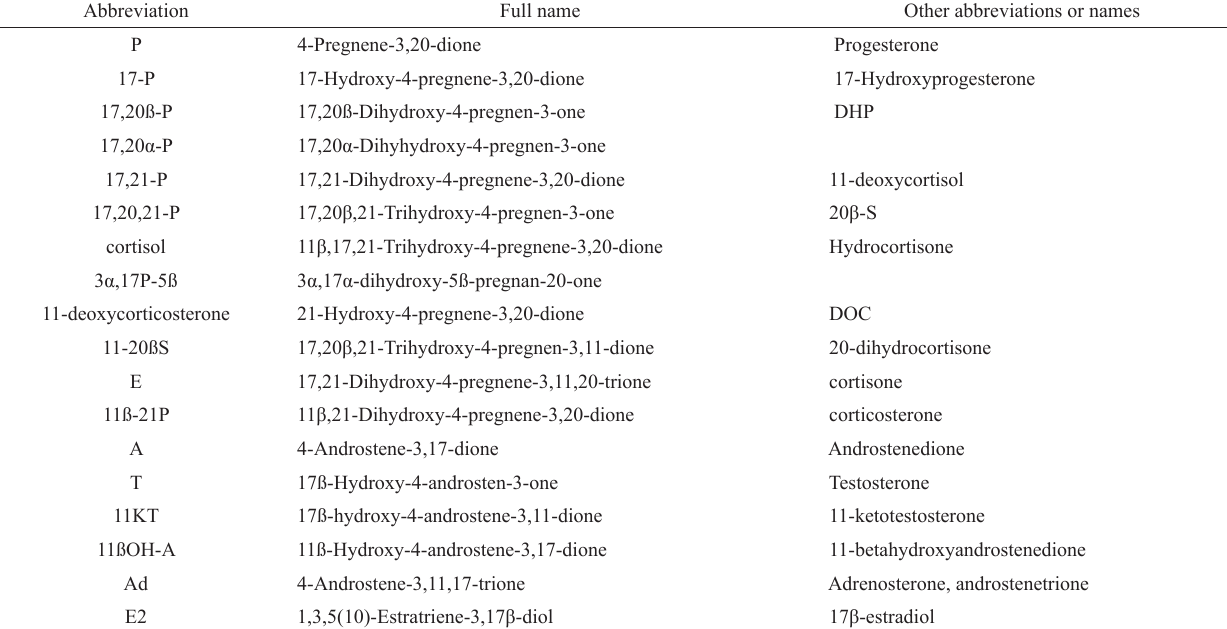
Table 1 . Meaning of common abbreviations used in text following Kime